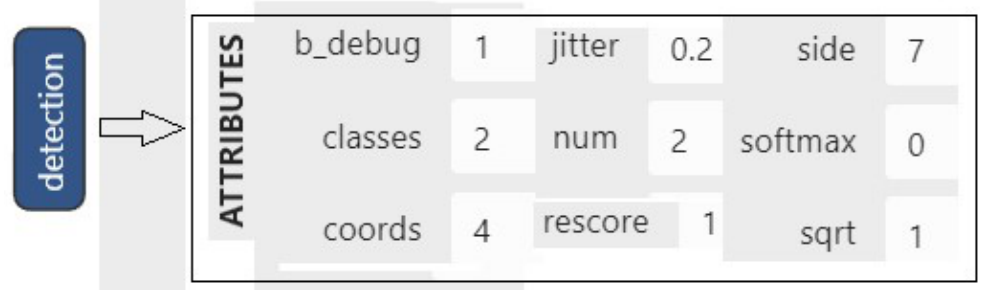
Figure 7. Attributes of output layer.